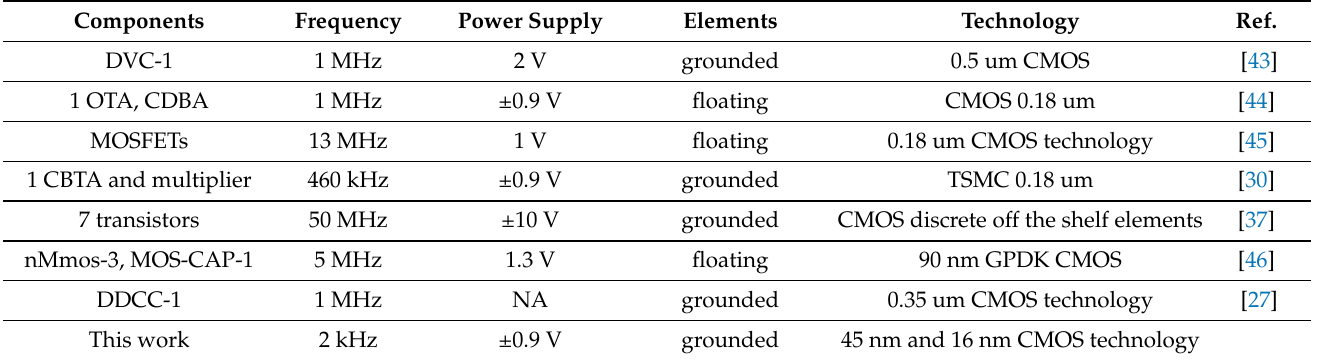
Table 1. Comparison of the proposed memristor with other presented memristor